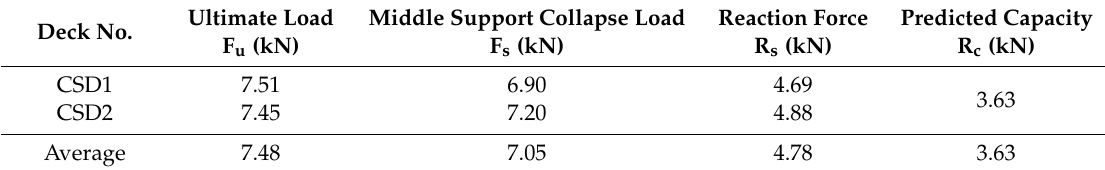
Table 5. Experimental and calculated results for continuous deck tests (experiment group (c)). Deck